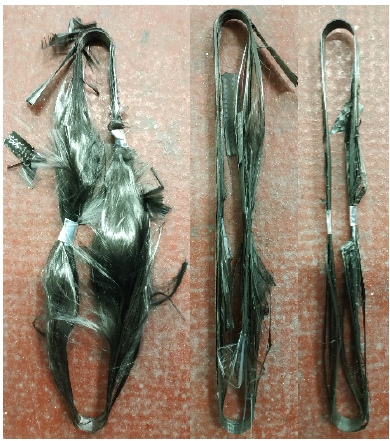
and ( c ) between 400 and 600 °C.